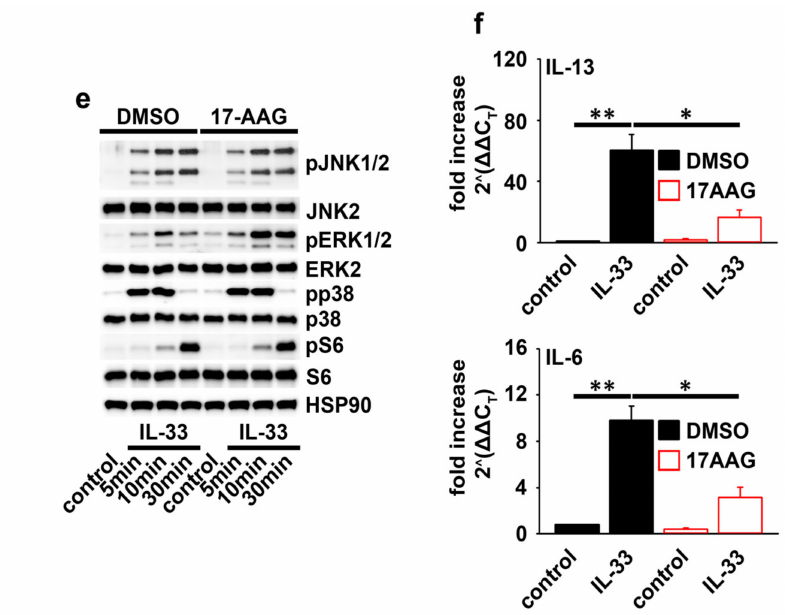
Figure 3. HSP90 mediates cytokine transcript stability. ( a ) BMMCs treated with DMSO (vehicle) or 17AAG (1 µ M) were stimulated with IL-33 (50 ng/mL) as indicated. Cells were lysed and analyzed by Western blotting (one representative Western blot experiment is shown). ( b ) P65/RelA − eGFP MC/9 cells were treated with DMSO (vehicle) or 17AAG (1 µ M) and were stimulated with IL-33 (50 ng/mL) for 24 h. Supernatants were collected and analyzed by ELISA (the summary of n = 3 replicates is shown; unpaired Student’s t − test; *** p ≤ 0.001). ( c ) P65/RelA − eGFP MC/9 cells were treated with DMSO (vehicle) or 17AAG (1 µ M) and were stimulated with IL-33 (50 ng/mL) for 24 h. Cells were harvested and analyzed for eGFP expression by flow cytometry (one representative experiment is shown). ( d ) Shown is the statistical analysis of the experiment shown in ( c ) (the summary of n = 5 replicates is shown; unpaired Student’s t -test; ns: not significant). ( e ) BMMCs were treated with DMSO (vehicle) or 17AAG (1 µ M) and were stimulated with IL-33 (50 ng/mL) as indicated. Cells were lysed and analyzed by Western blotting (one representative Western blot experiment is shown). ( f ) BMMCs were treated with DMSO (vehicle) or 17AAG (1 µ M) and were stimulated with IL-33 (50 ng/mL) for 6 h. Cells were harvested and analyzed by qPCR (the summary of n = 3 biological replicates is shown; unpaired Student’s t − test; * p ≤ 0.05, ** p ≤